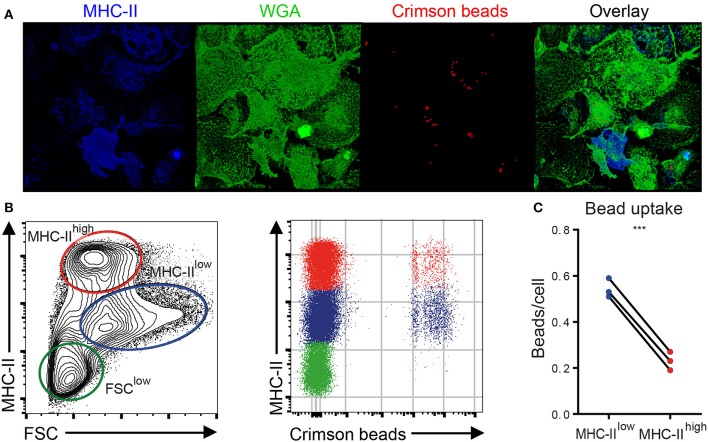
Major histocompatibility complex class II (MHC-II)low chicken bone marrow-derived dendritic cells (chBMDCs) phagocytose IgY-coated beads more efficiently than MHC-IIhigh chBMDCs. (A) chBMDCs were stained with wheat germ agglutinin (WGA) to visualize the plasma membrane, shown in green, and MHC-II to identify MHC-IIhigh cells, shown in blue, by confocal microscopy. Fluorescent crimson beads are shown in red. A 3D image was constructed from 56 z-stacks over a total distance of 9.4 μm. Here, a top view on the 3D image is shown, whereas all dimensions are visible in Supplementary Video 1. (B) Next, the bead content was quantified by flow cytometry for the previously identified chBMDC subpopulations. (C) The average number of beads per cell was calculated for MHC-IIlow and MHC-IIhigh subpopulations by dividing the mean fluorescent intensity (MFI) of the fluorescent beads by the MFI of cells that contained one bead (visible in B as the first positive line of cells). Each line represents an independent replicate (n = 3). A statistically significant difference between chBMDC subsets is shown/indicated by ***p < 0.001.